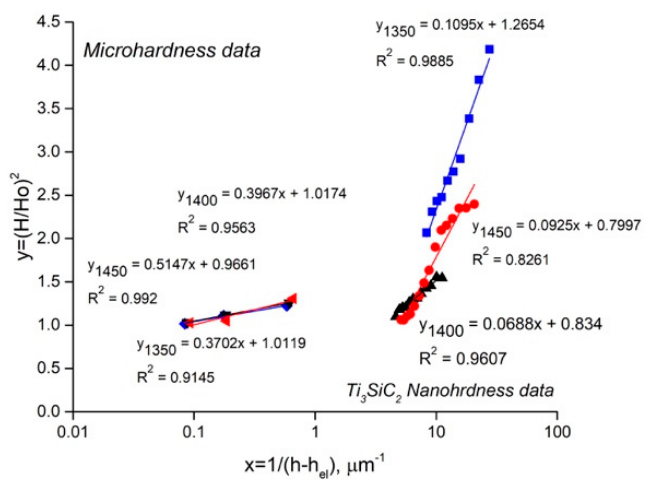
Figure 11. Application of the Nix and Gao model to composites and Ti 3 SiC 2 phase of composites SPSed at 1350, 1400 and 1450 ◦ C. at 1350, 1400 and 1450 °C.